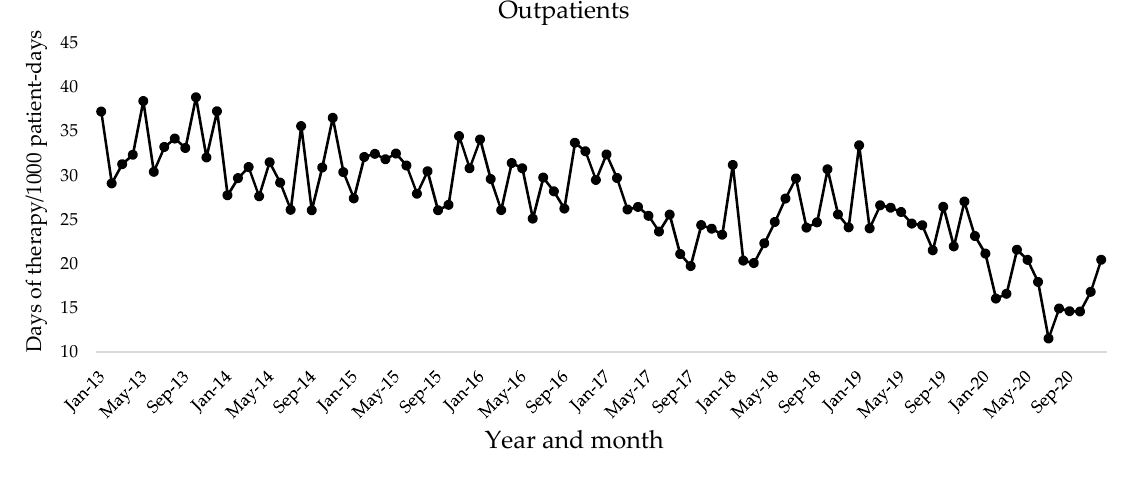
Figure 1. Monthly days of therapy per 1000 patient-days of oral quinolones in outpatients.